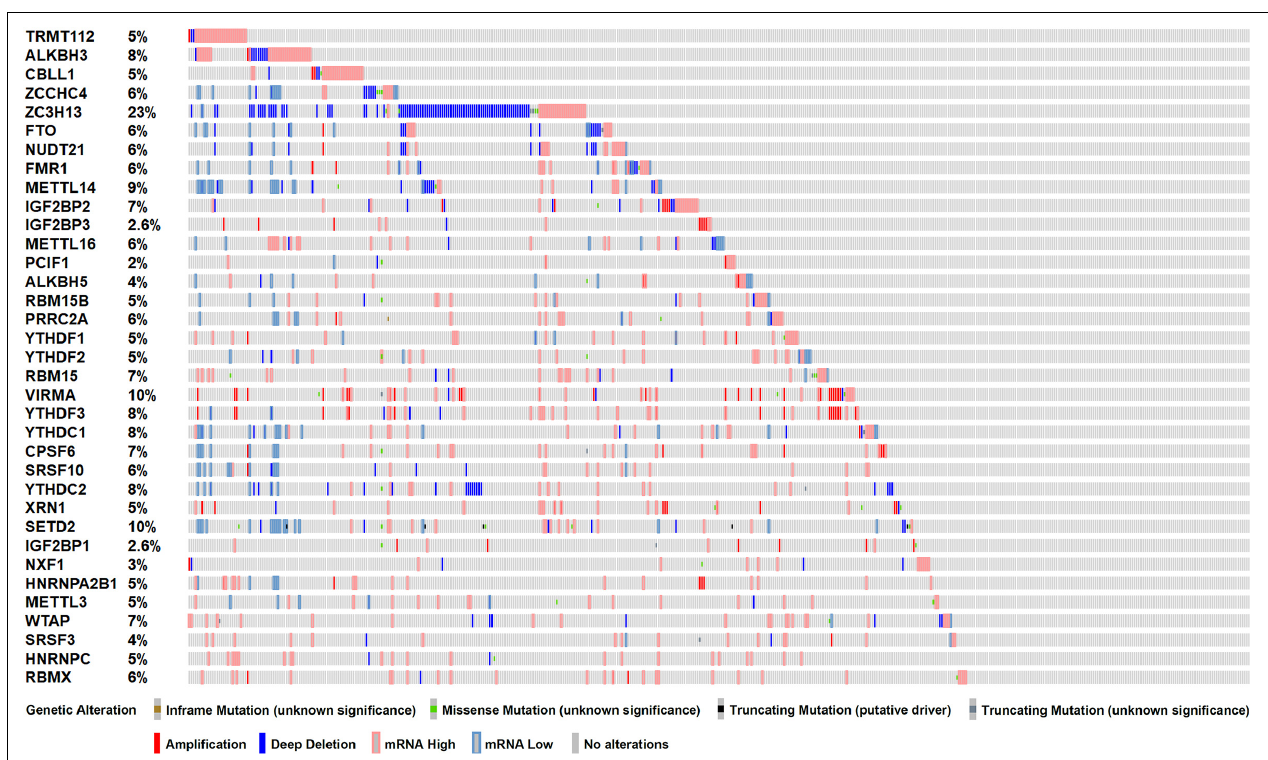
FIGURE 1 | Genetic alterations of m 6 A RNA methylation regulators in TCGA-PRAD cohort ( n = 499). Mutations include inframe mutation, missense mutation, and truncating mutation. Copy-number alterations (CAN) include amplification and deep